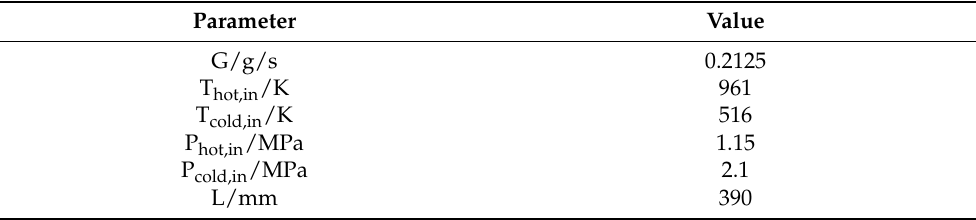
Figure 22. PCHE model for numerical simulation of the fine engraving process and etching process by Yang and Huo [30]. Table 12. Boundary conditions for single-channel heat transfer calculations by Yang and Huo [30].